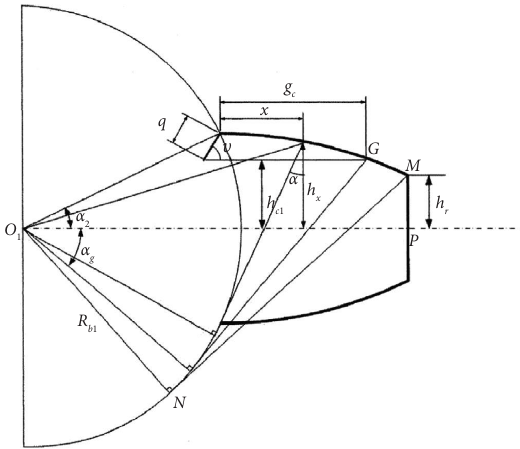
Figure 8: Modeling of a gear tooth crack.